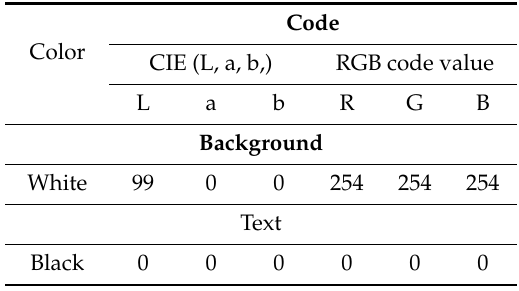
Table 1. CIE coordinate values (L, a, b) and RGB